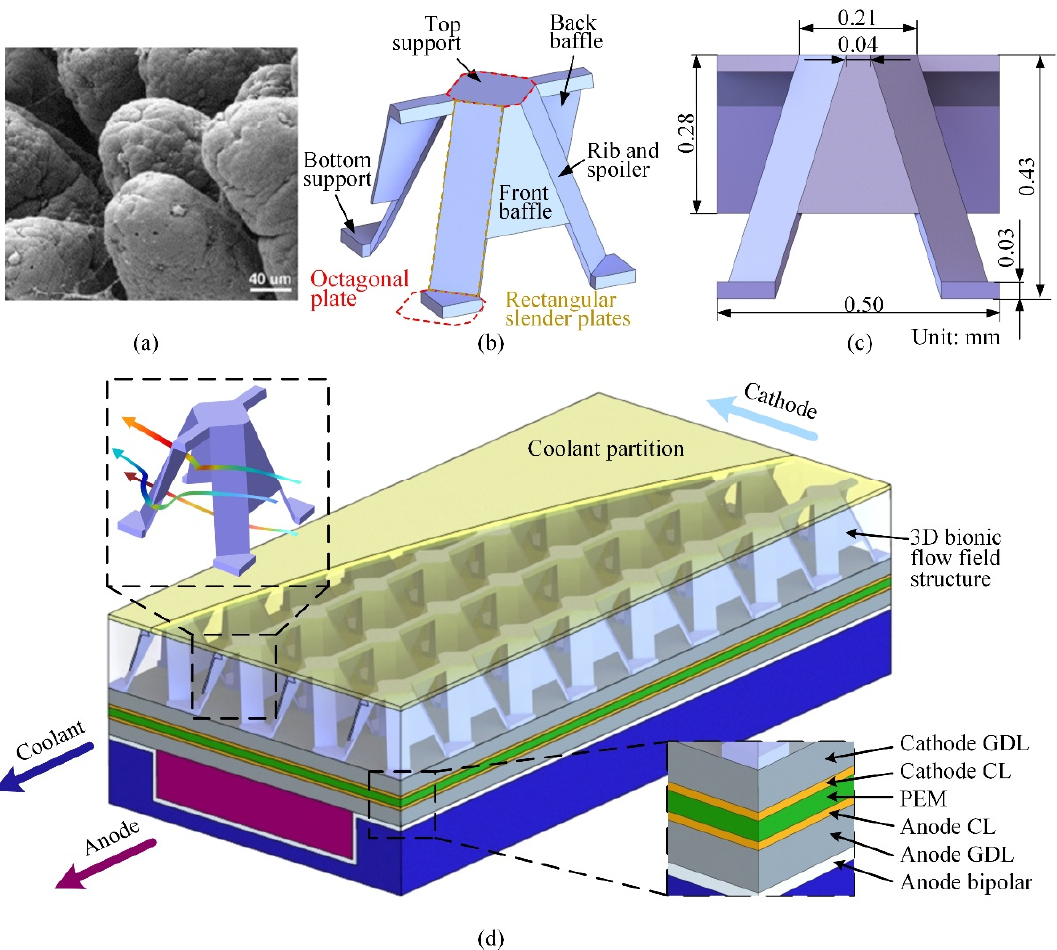
Figure 1. ( a ) SEM image of small intestine villi [27]. Reproduced with permission [27]. Copyright 2007, Elsevier. ( b ) The 3D bionic designed unit, ( c ) geometric parameters of the 3D bionic unit, ( d ) overall structure of the final designed 3D bionic flow field of the fuel cell.